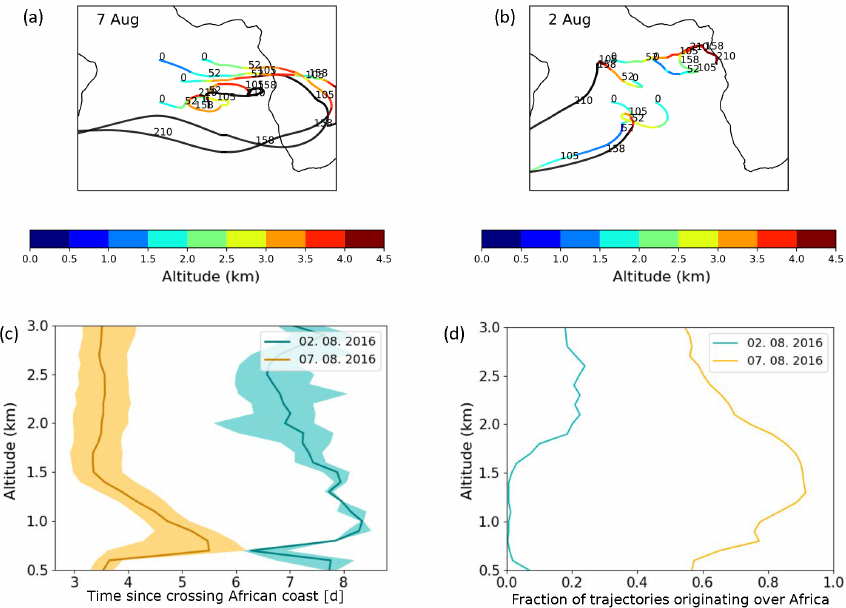
Figure 3. Trajectories (a, b) from the global model for 10 days prior to 2 August (a, c) and 7 August (b, d) calculated backwards from the centre and the four corners of the regional model domain at 1500m altitude. The numbers along each path correspond to the number of hours backwards along the air mass trajectory. Below, the fraction of back-trajectories on 2 August (blue) and 7 August (orange) that pass over the African continent in the 10 days before they reach the regional model domain are shown. The right-hand plot shows the time taken for the trajectories that do cross the continent to reach the region on the two dates. The shaded bands show the inner half of the distribution. At each of 25 different altitudes, 330 sample trajectories were calculated, spaced evenly across the model domain. This is a large sample, but the width of the distribution for the case of 2 August is limited by the sample size below 1.5km altitude because so few trajectories come from